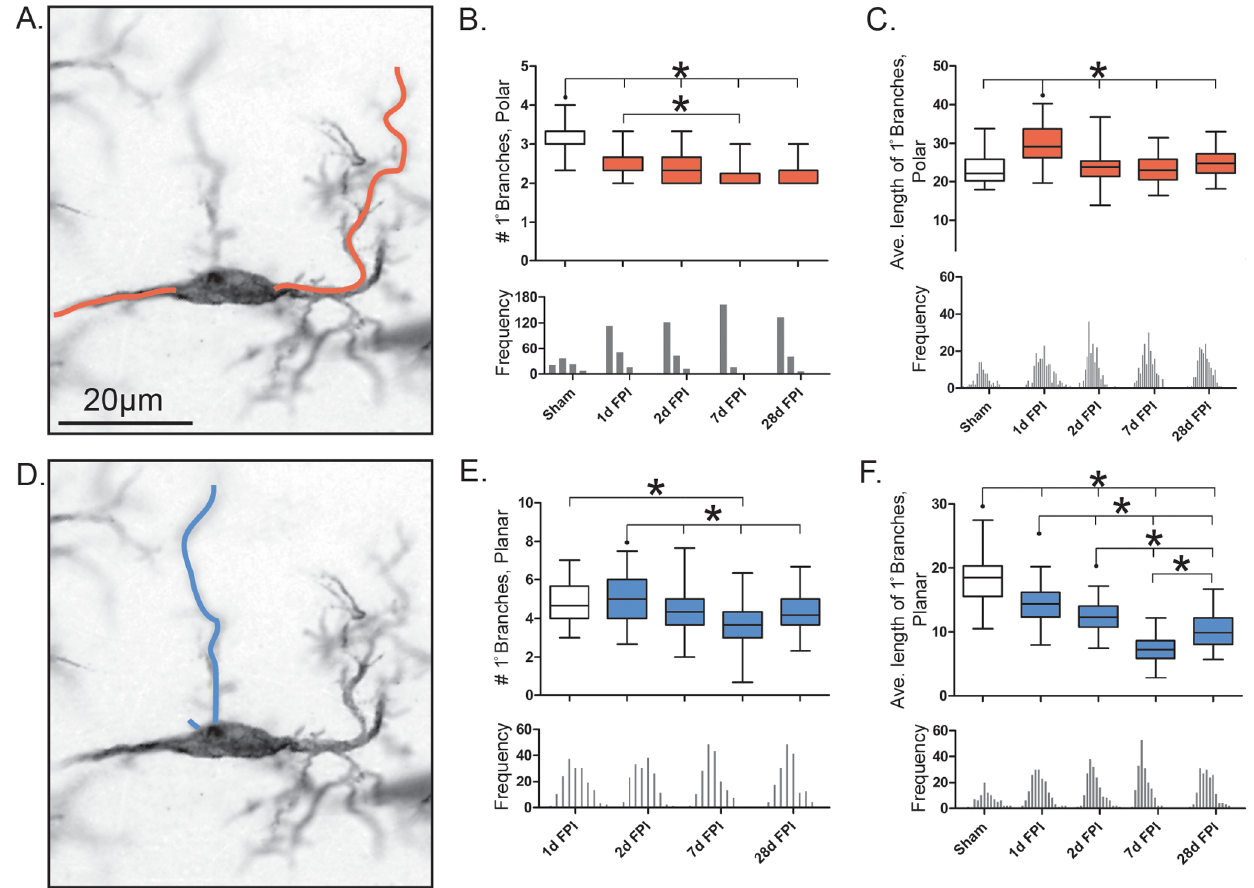
Figure 4. Retraction of rod microglial branches post-injury. (A, D) representative 28 day post-FPI Iba1-positive rod microglia, 100x. The orange and blue lines illustrate the measured primary polar and planar branches respectively. (B, E) Number of primary branches present on cell, polar and planar respectively. (C, F) Average length of the primary branches present on the cell ( m m), polar and planar respectively. Populations described by a box and whisker plot. Notches of each frequency histogram represent the bin center for that specific time point. Unlike the average length of primary polar branches, the number of primary polar branches is heavily weighted to the left of the mean (negatively skewed). All other histograms show a Gaussian distribution. Significance was calculated using the mean values for each time point (n=3/time point; *, P , 0.05, one-way ANOVA).